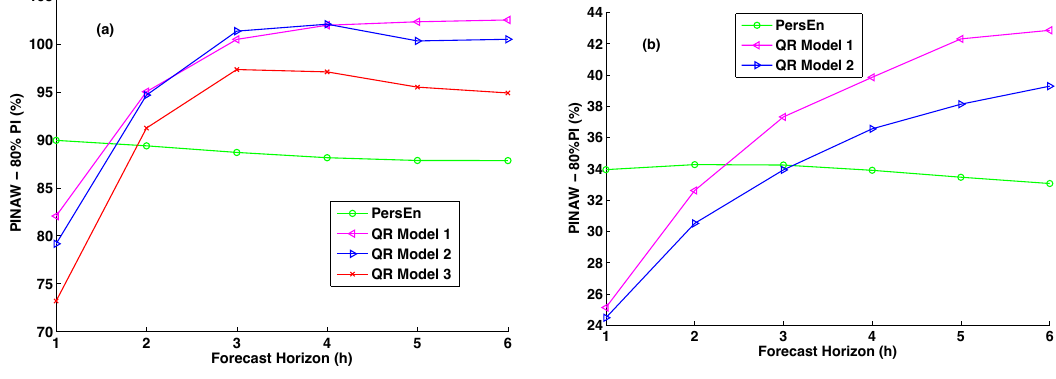
Figure 7. ( a ) PINAW for the 80% nominal coverage rate: site of Le Tampon; ( b ) PINAW for the 80% nominal coverage rate: site of Desert